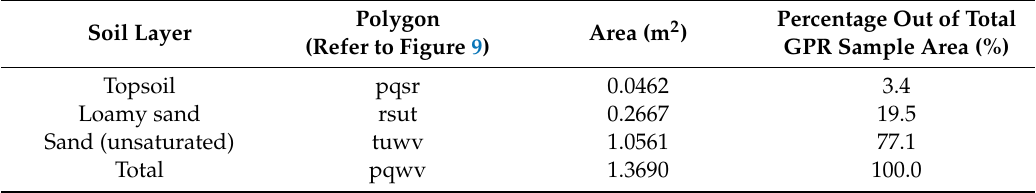
Table 3. Percentage sample area of each soil layer out of the total ground penetrating radar (GPR) sample area related to twelve GPR traces collected from the top of the soil moisture probes on the vertical plane of the GPR survey (refer to Figure 10).